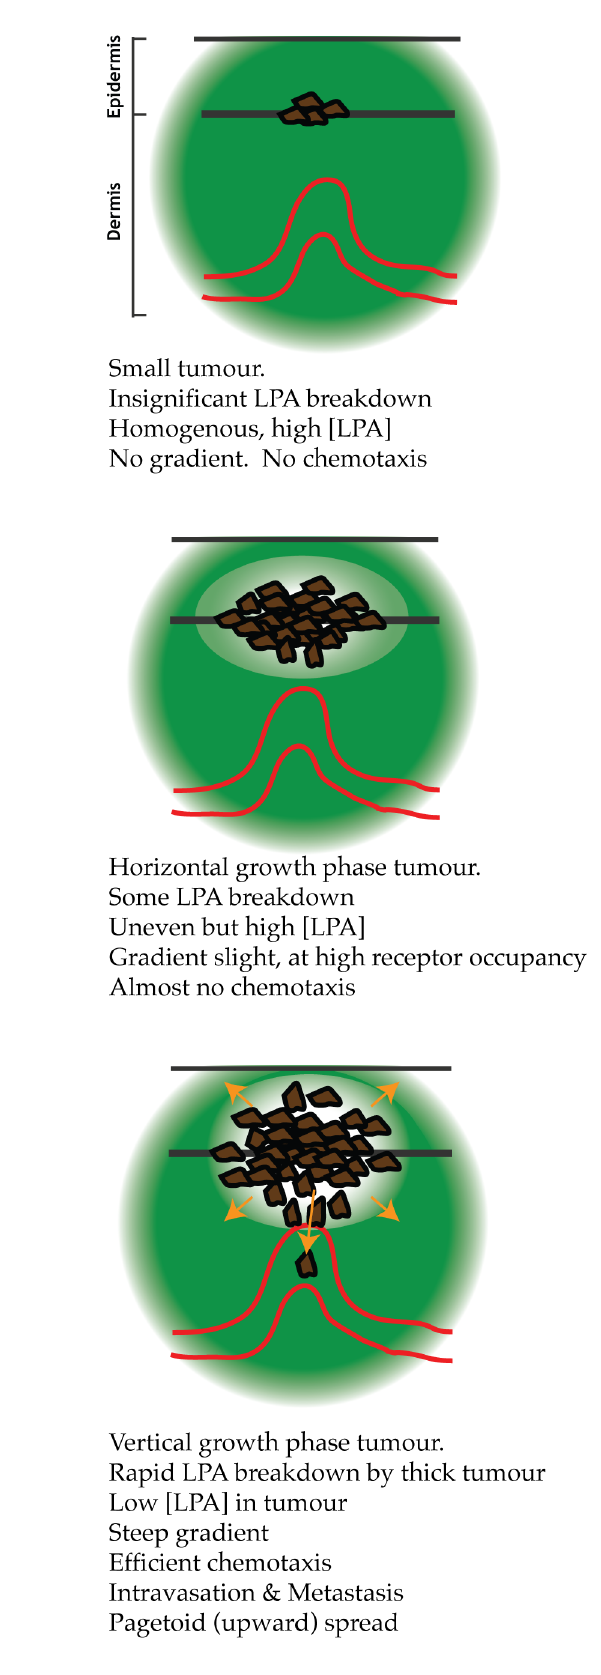
Figure 9. Schematic model of self-generated LPA gradients in melanoma. Like all schematics, this model is intended to clarify the underlying mechanism rather than as a detailed description. In small tumours, the rate of LPA breakdown is insignificant compared to the rates of synthesis and diffusion. Thus although the concentration of LPA is high, there is no gradient, and thus no directional signal. As the tumour becomes thicker—corresponding to an increased Breslow depth—the concentration of LPA at the centre of the tumour drops as the rate of breakdown increases and the distance that LPA must diffuse increases. This generates an LPA gradient that is low inside the tumour and high outside, driving cells to migrate out from the tumour into the